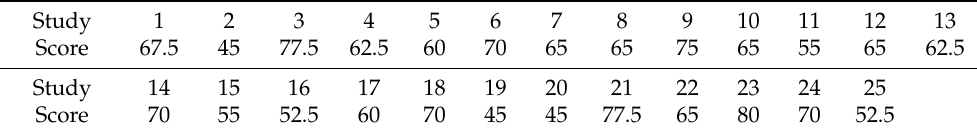
Table 3. Bias assessment for internal validity for each